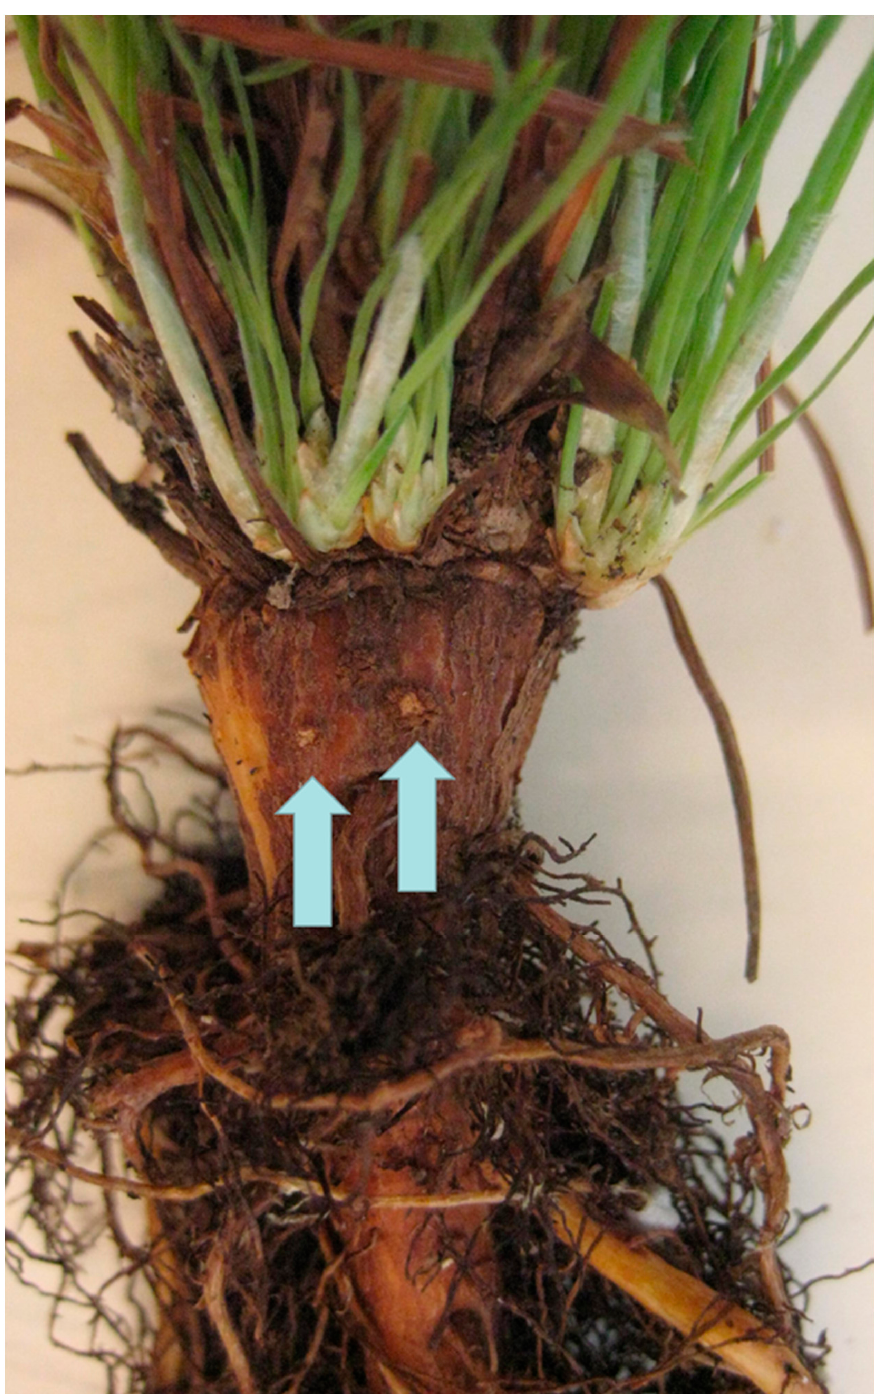
Figure 26. Example of two lenticles on the root of a container-grown longleaf pine